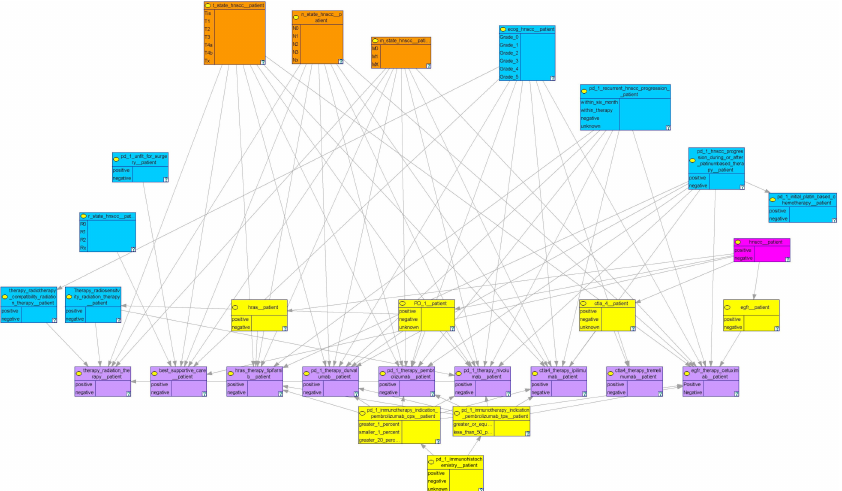
Figure 2. An overview of the complete model. Thematically related variables share the same color. Orange: TNM, yellow: Immunohistochemistry and genetic targets; pink: HNSCC, blue: additional conditions to match indications or treatment conditions; lilac: drugs and other therapeutic